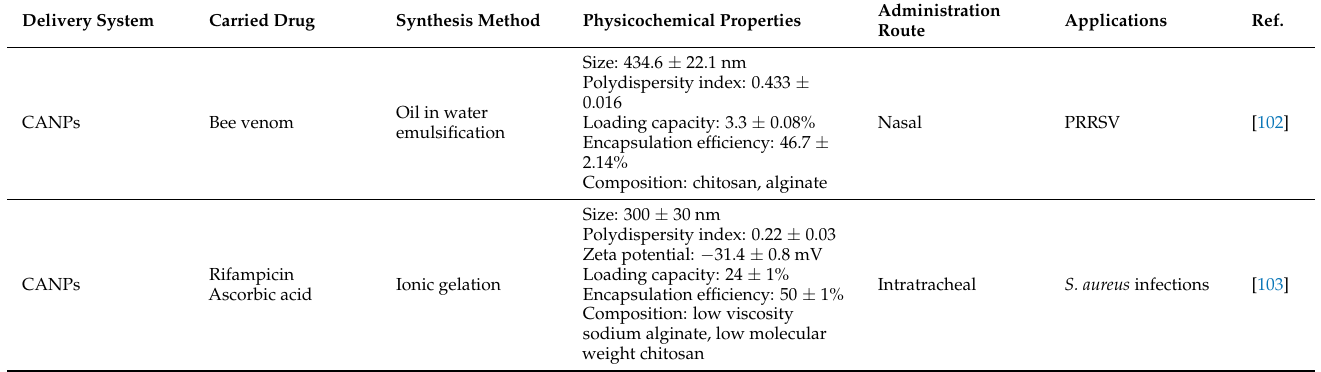
Table 3. Examples of chitosan-alginate nanoparticles for various administration